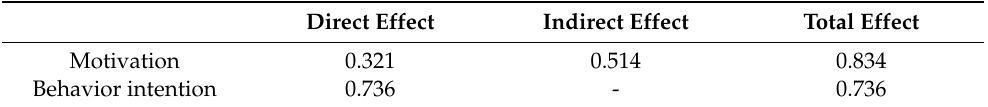
Table 5. Mediation effect of